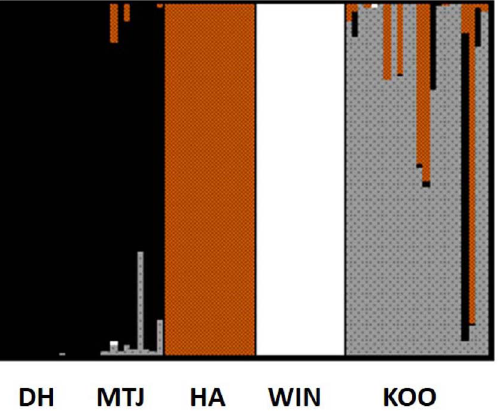
Figure 3. Bayesian population assignment of Atelomastix bamfordi individuals generated in TESS for the optimal grouping of K=4. Each vertical line represents an individual and the colour displays the probability of belonging to each genetic cluster.